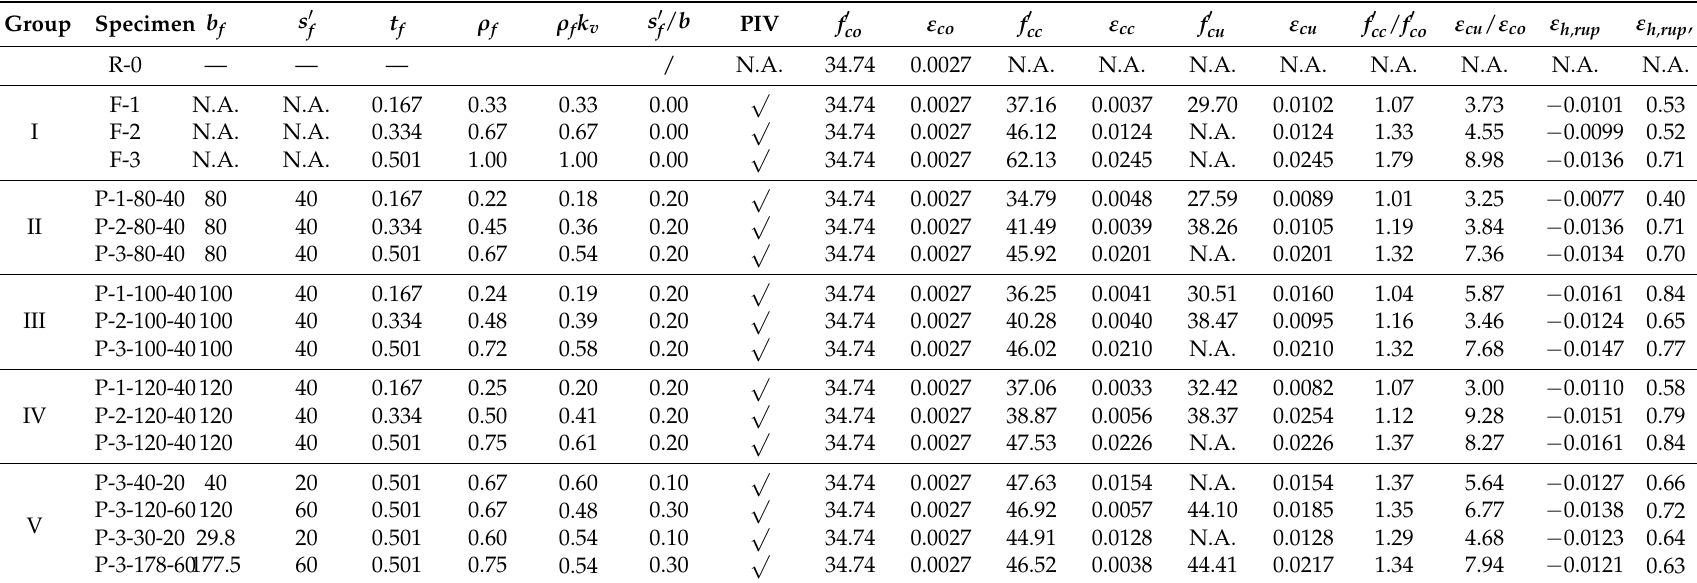
Table 1. Details of specimens and key test